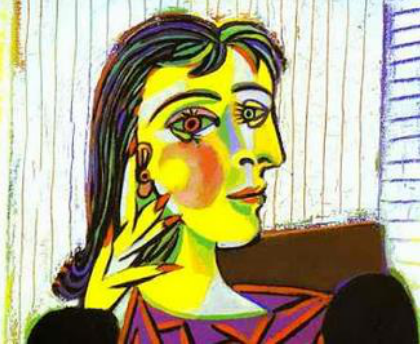
Fig. 24 Portait of Dora Maar (Picasso, 1937)